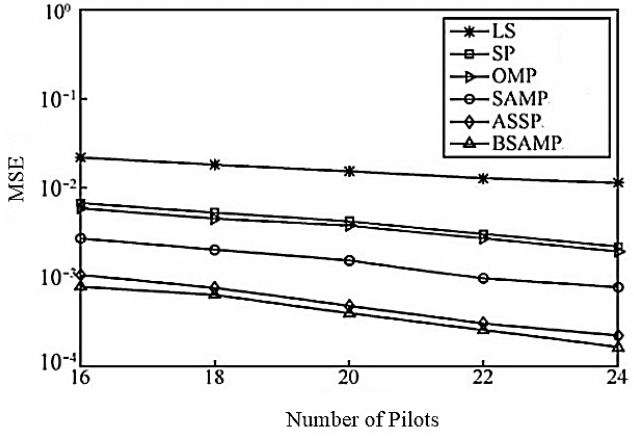
Figure 5. Comparison of MSE for each algorithm under a different number of pilots.